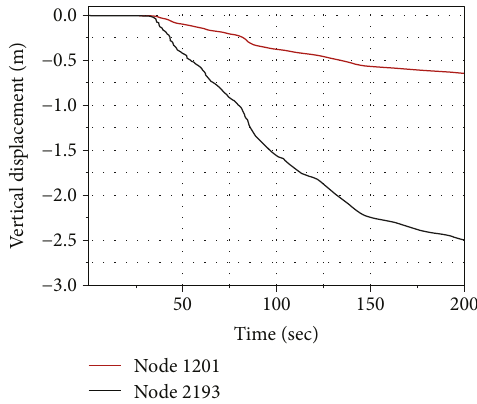
Figure 17: Time history of vertical displacement for node 1201 and node